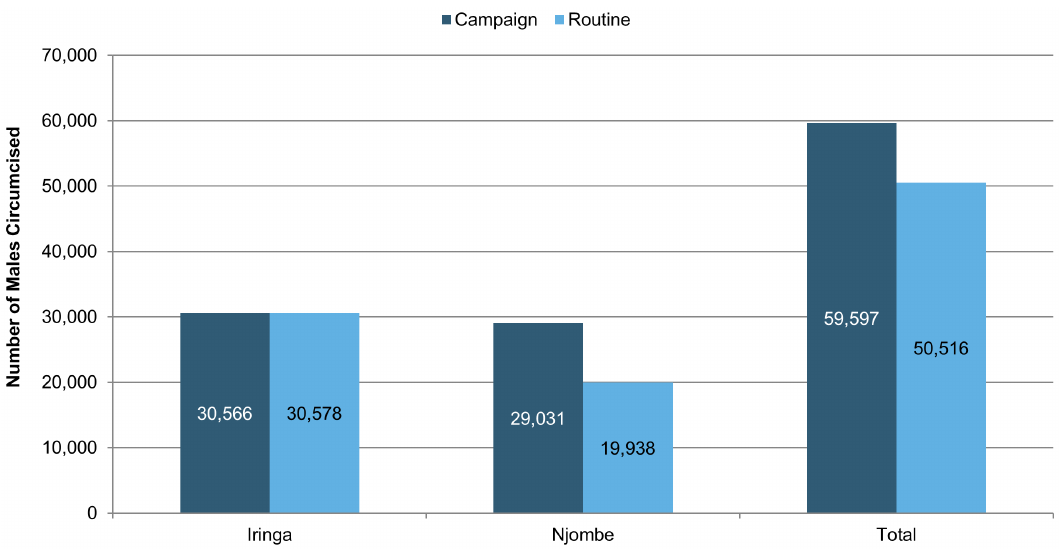
Figure 3. Total number of VMMC procedures in Iringa and Njombe regions, Tanzania, October 2009 to December 2012.